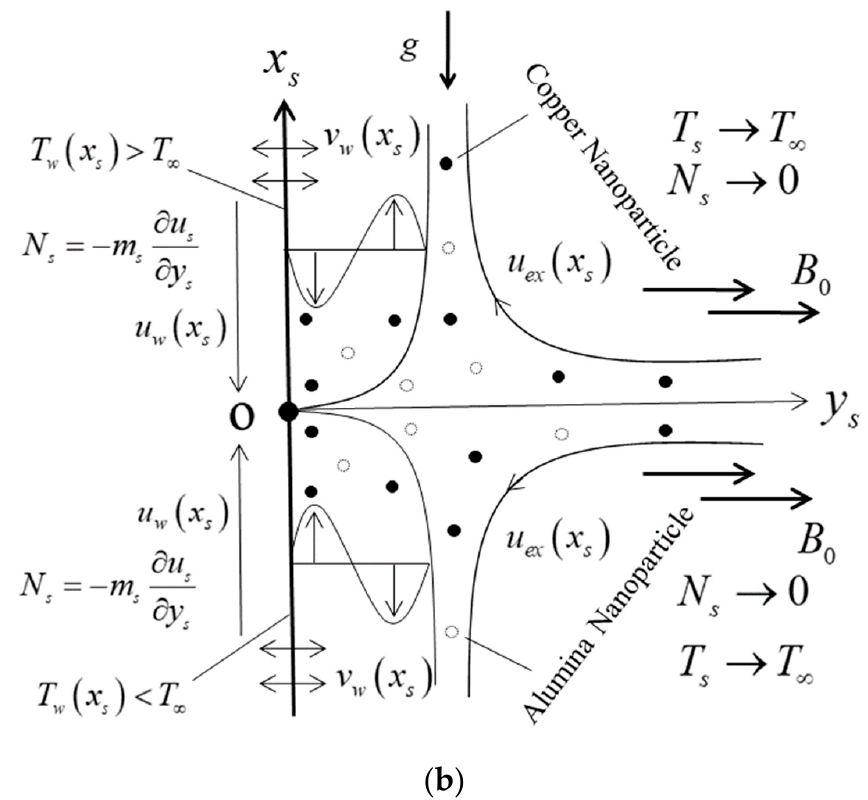
Figure 1. Physical model and coordinate system ( a ) Stretching sheet; ( b ) Shrinking sheet.